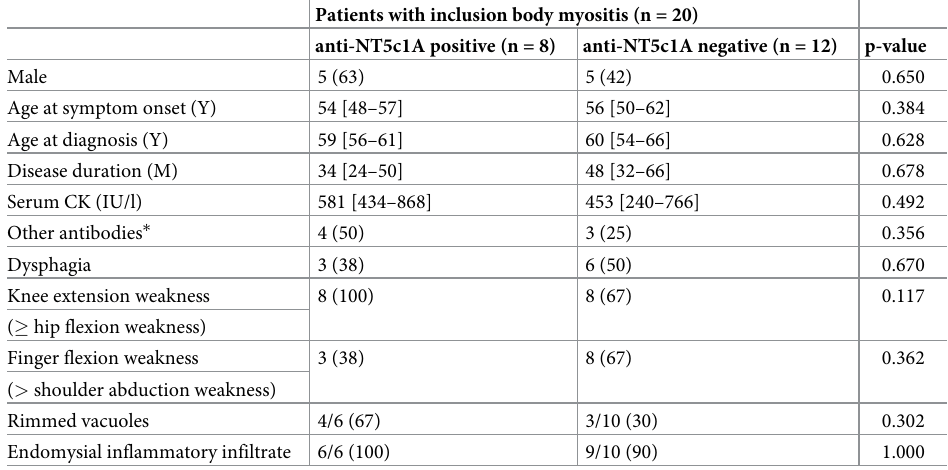
Table 3. Clinicopathological features of 20 patients with inclusion body myositis according to anti-NT5c1A anti- body status. Patients with inclusion body myositis (n =